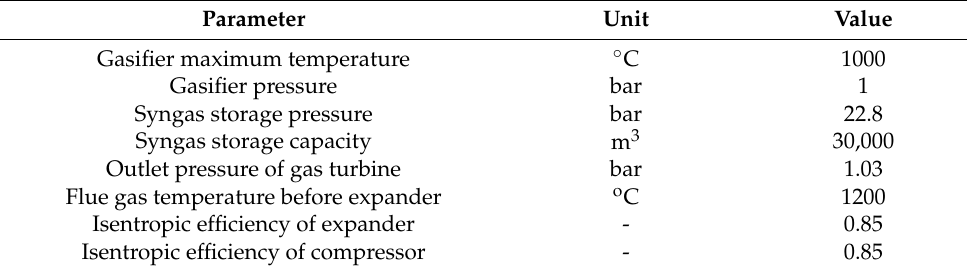
Table 2. Parameters of the system.